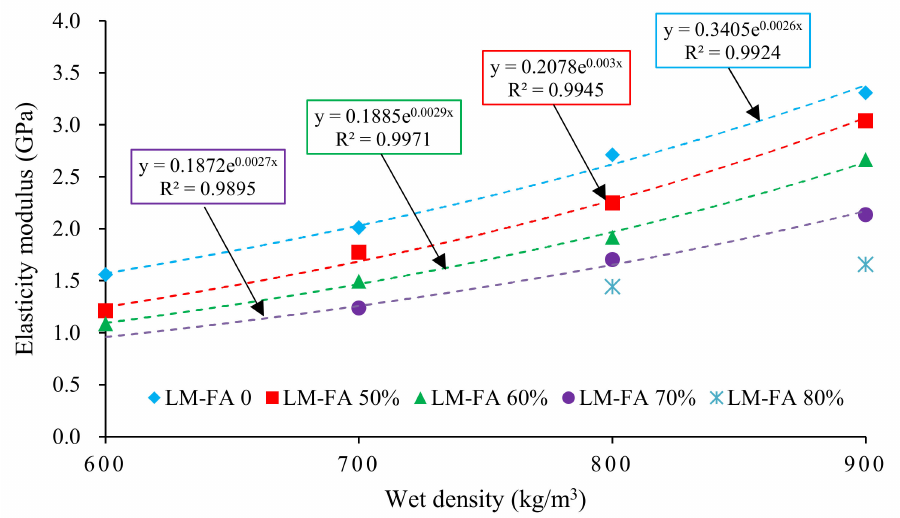
Figure 8. The elasticity modulus of Series II